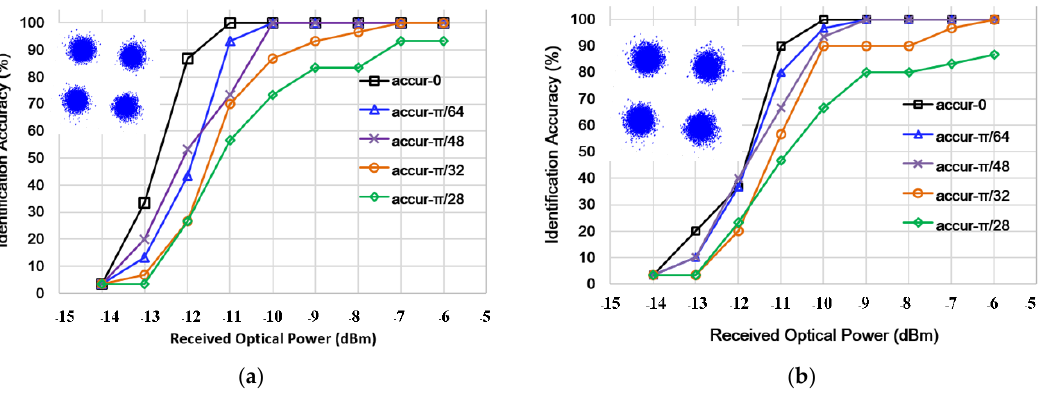
Figure 7. The identification accuracy under different residual phase rotation for ( a ) OBTB and ( b ) 25 km SSMF configurations. 4-QAM rotated constellation diagram for the additional phase rotation of π/32 at a specific RoP (−11 dBm) is embedded.